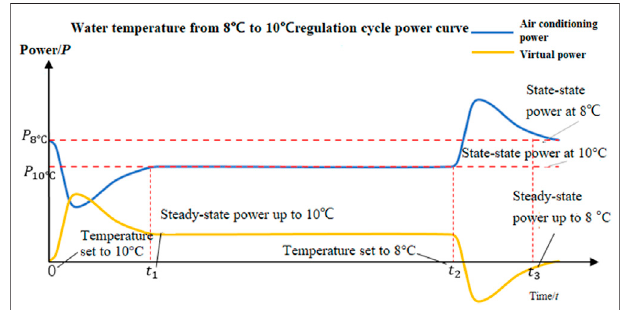
FIGURE 2 | Power variation under T Chilled going from 8 ° C to 10 °